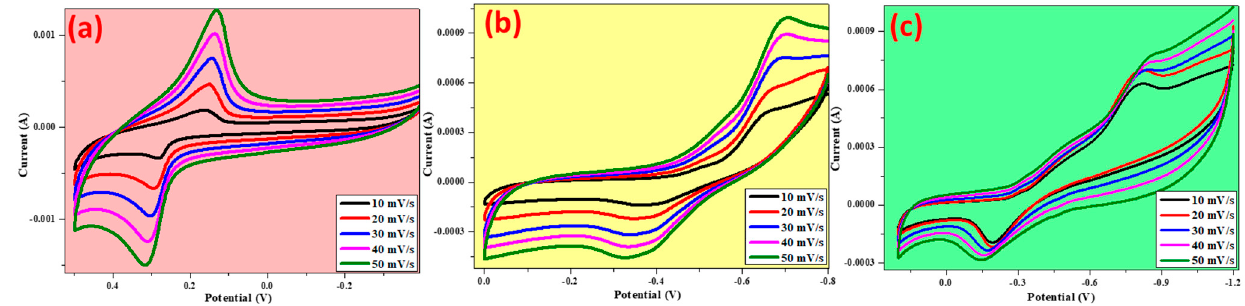
Figure 9. Cyclic voltametric studies of prepared metal oxides ( a ) NiO, ( b ) CuO, ( c ) ZnO in 0.1M KOH.